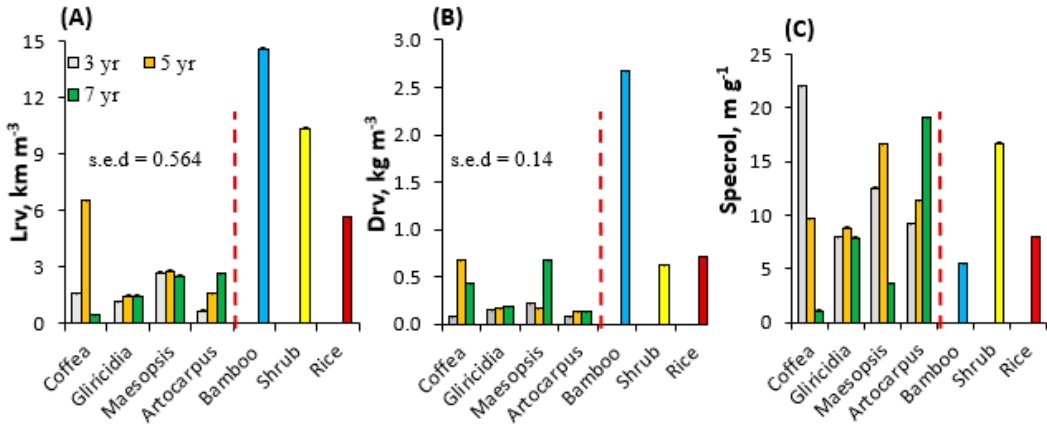
Figure 5. ( A ) Root length density (L rv ), ( B ) root dry weight (D rv ), and ( C ) specific root length (L rv /D rv )